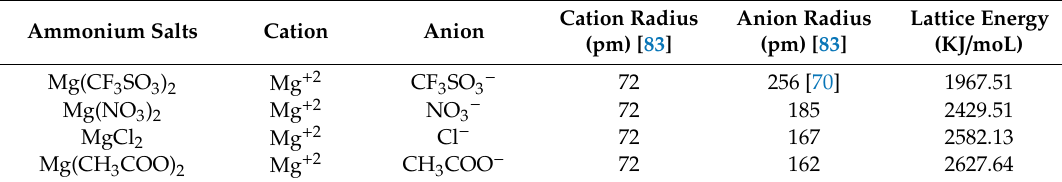
Table 6. Lattice energy for some of magnesium salts.